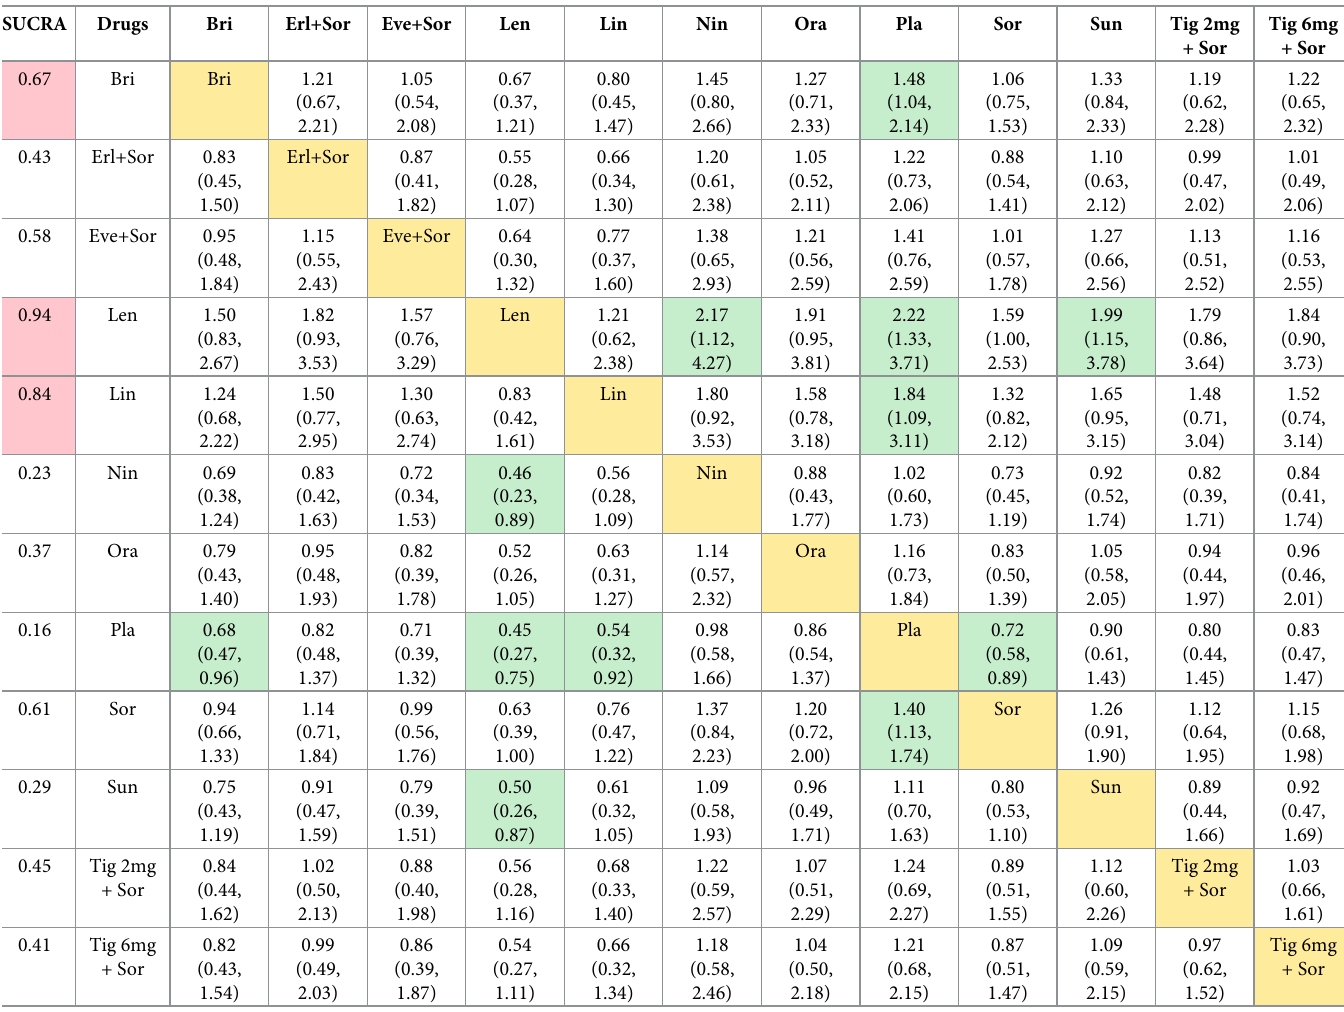
Table 2. Network meta-analyses for TTP (Findings are expressed as HR (95% CrI), use of random-effect